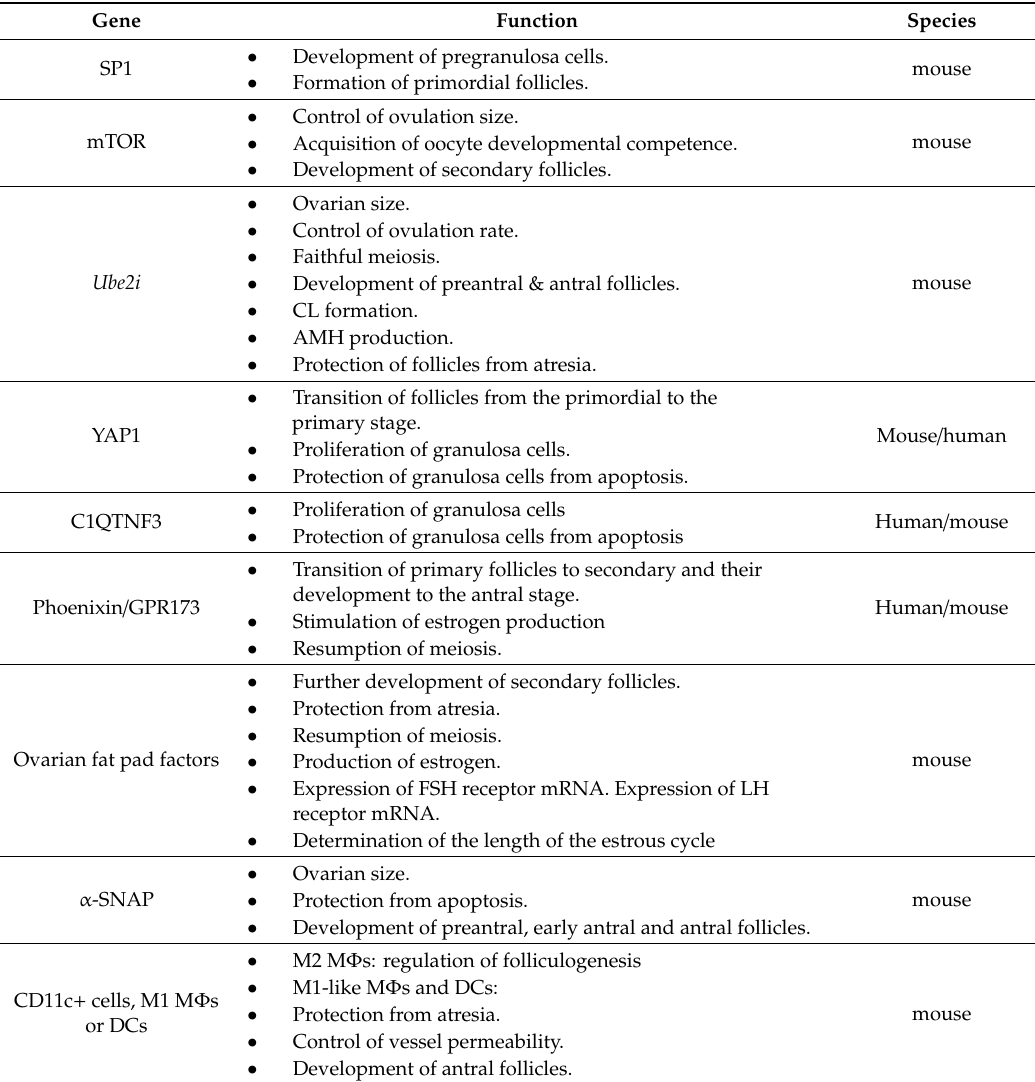
Table 1. Newly identified regulators of